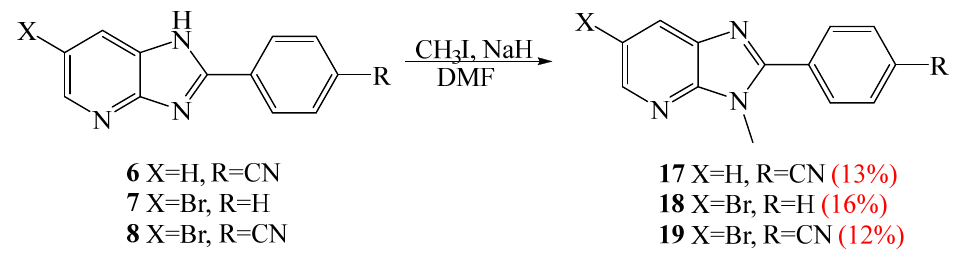
Table 1. In vitro antiproliferative activity against a broad panel of cancer cell